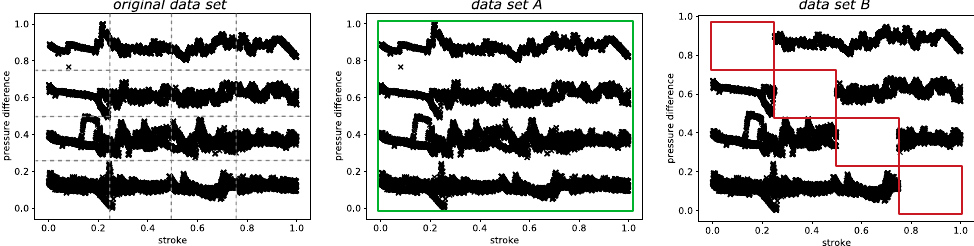
Figure 16. Scatter plots of stroke and pressure difference for the original data set ( left ), data set A with random deletion of observations ( center ) and data set B with deletion of observations in dis ‐ Figure 15. Visualization of data set completeness of ( a ) the original data set, ( b ) data set A and ( c ) tinct sections ( right ). data set B.